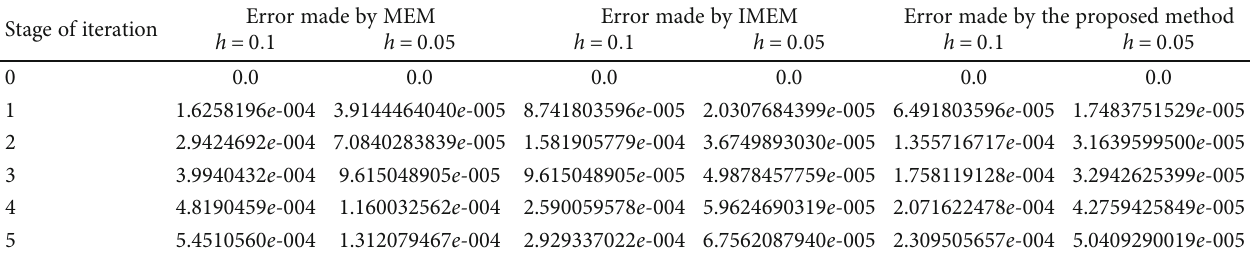
Table 6: Absolute error made for Example 3. Error made by MEM Stage of iteration